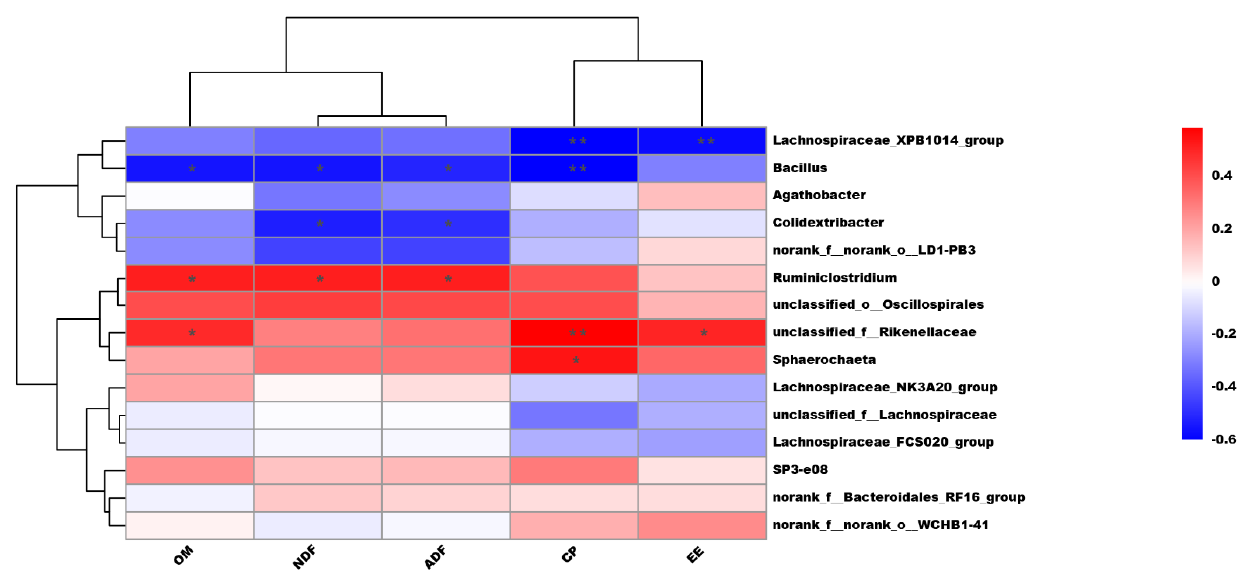
Figure 3. Correlation matrix between the differential ruminal bacterial genera and nutrient digestibility. * 0.01 < p < 0.05, ** p < 0.01.